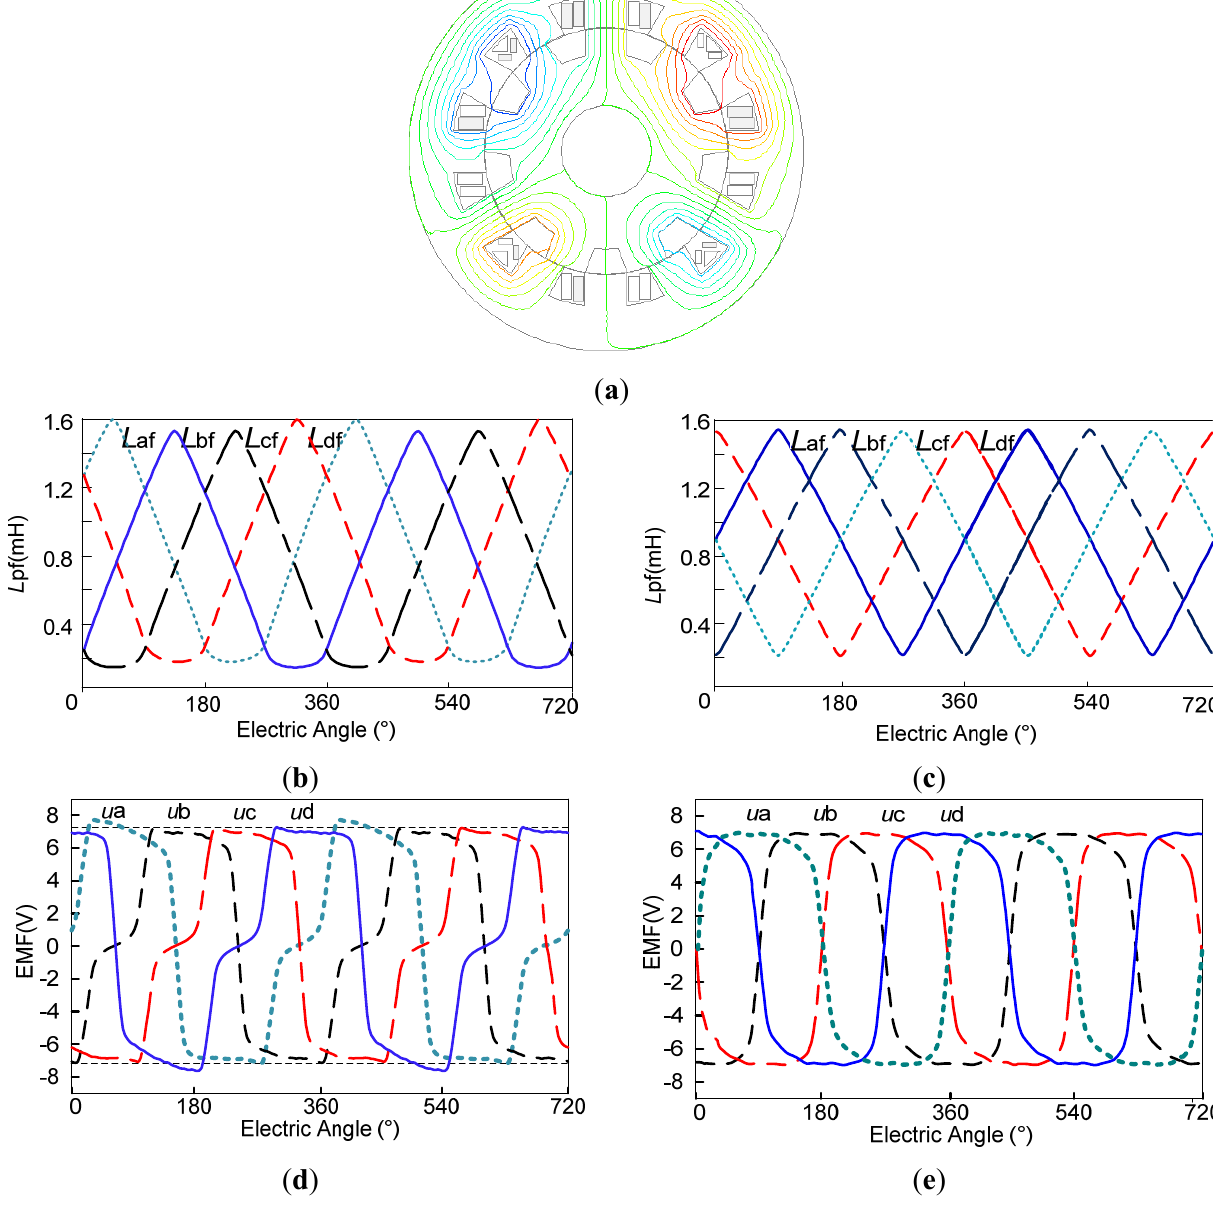
Figure 7. Comparison of the traditional and the new four-phase WFDSM. ( a ) The flux of the 12/9-pole WFDSM; ( b ) L pf of the traditional 8/6-pole WFDSM; ( c ) L pf of the new 12/9-pole WFDSM; ( d ) Back EMF of the 8/6-pole WFDSM; ( e ) Back EMF of the 12/9-pole